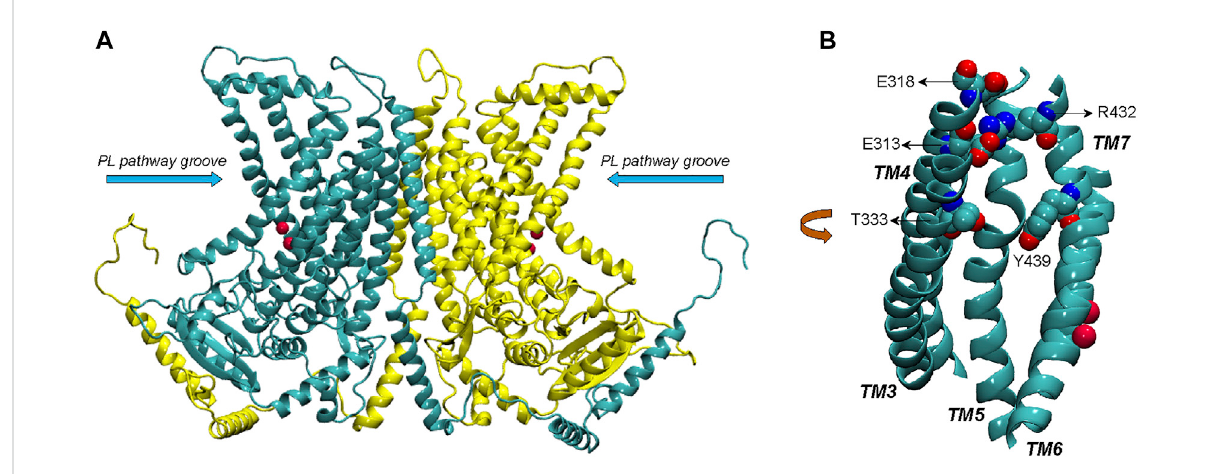
FIGURE 1 (A) Complete structural model of nhTMEM16 dimer (based on PDBID 4WIS). The two monomers of the dimer are indicated in cyan and yellow color, respectively. The phospholipid (PL) pathway groove region is indicated, and the bound Ca 2+ ions (two per each monomer) are shown as red spheres. (B) View of the groove area (TMs 3 – 7) of one of the monomers, highlighting the EC network of polar residues (E313, E318, R432, T333, and